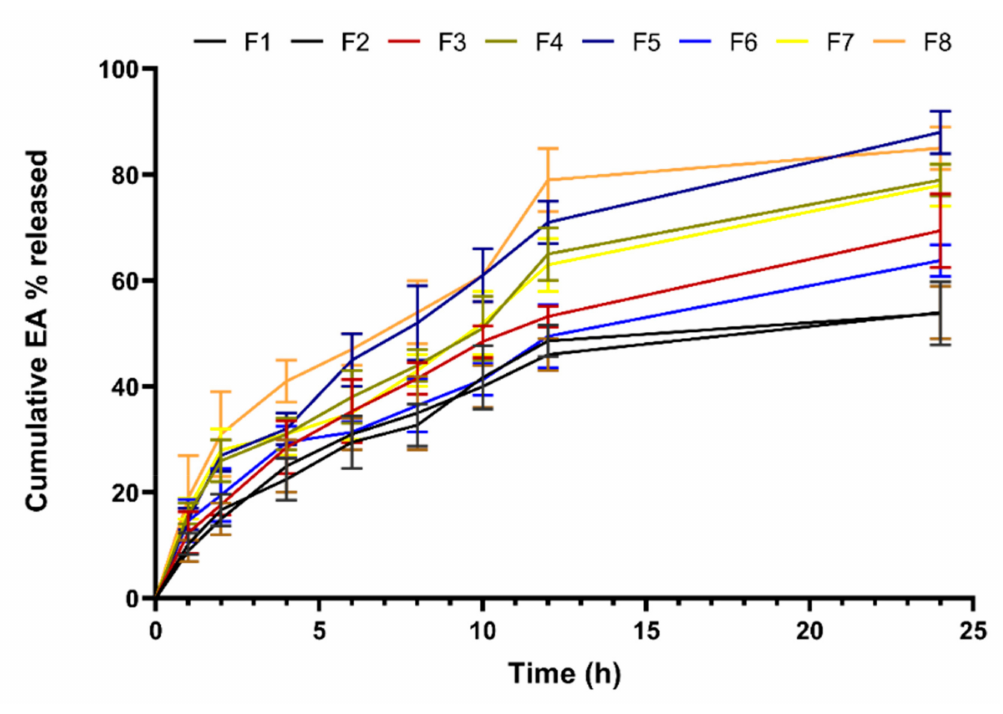
Figure 4. Release of EA from di ff erent EA–Ca pectinate floating beads prepared according to the 2 3 factorial